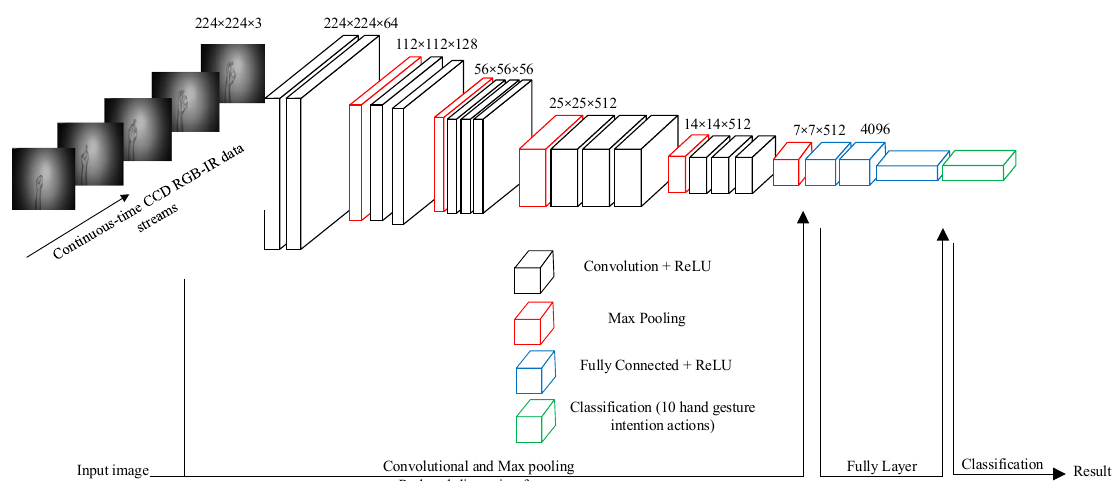
Figure 1. Frameworks of VGG-16 CNN deep learning [24] for the continuous-time hand gesture data stream (10 gesture classification nodes set in the final layer).